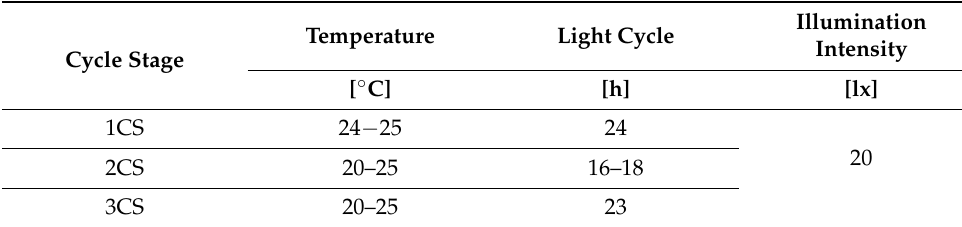
Table 2. Summary of basic parameters required for each stage of the